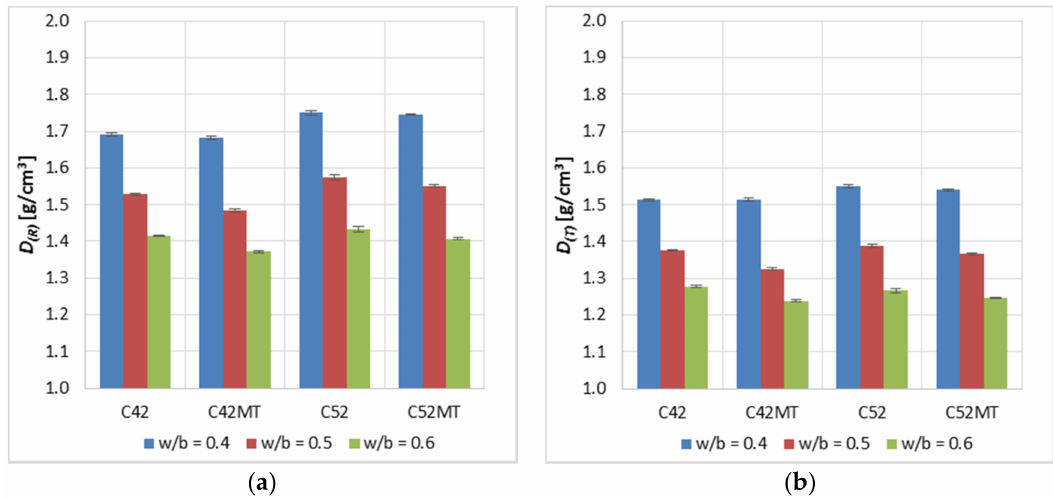
Figure 5. Average bulk density D of the modified cement pastes (error bars mean standard deviations): ( a ) reference samples; ( b ) samples after thermal